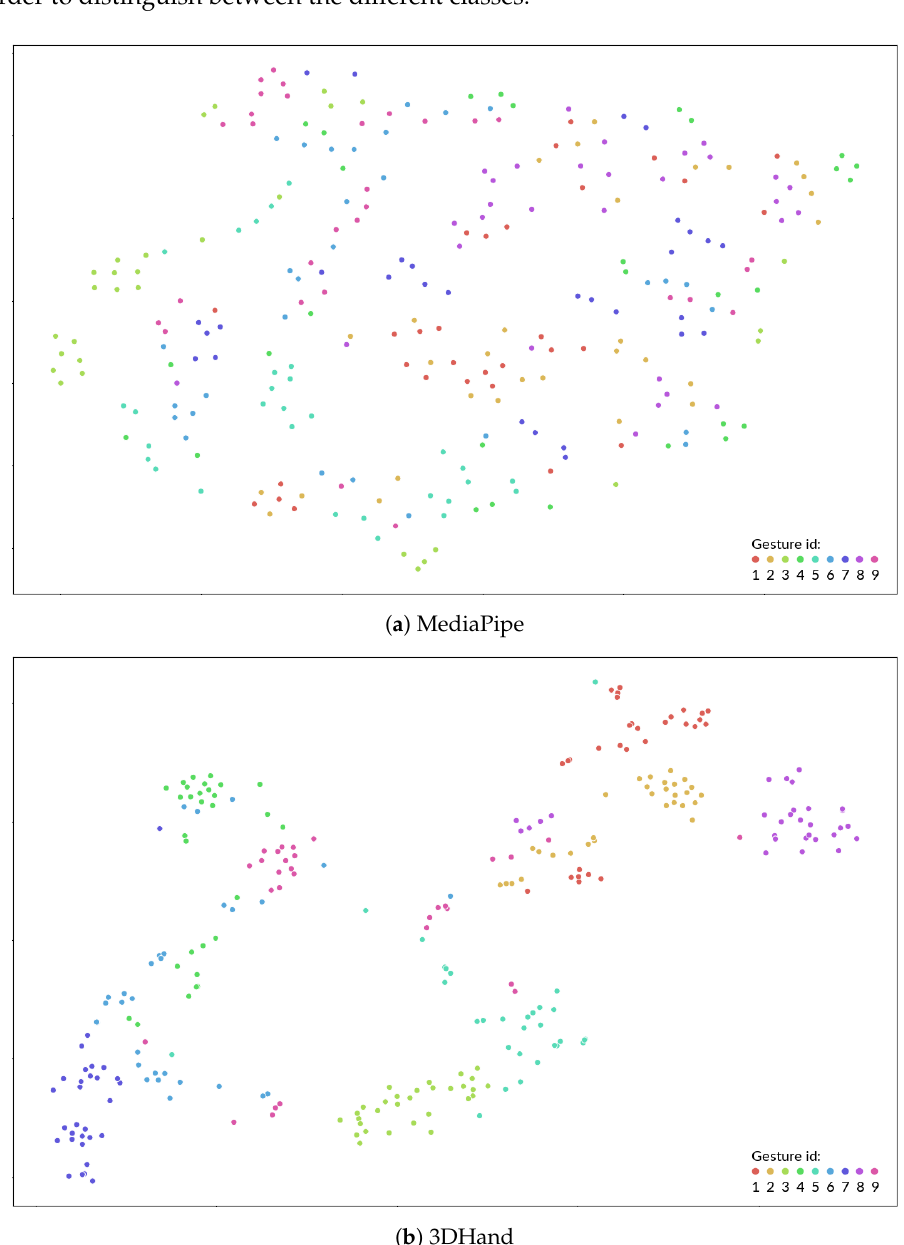
Figure 34. 2D embedding of joints for the nine gestures with 30 samples for each, calculated using t-SNE. Joints calculated using the ( a ) MediaPipe and ( b ) 3DHand